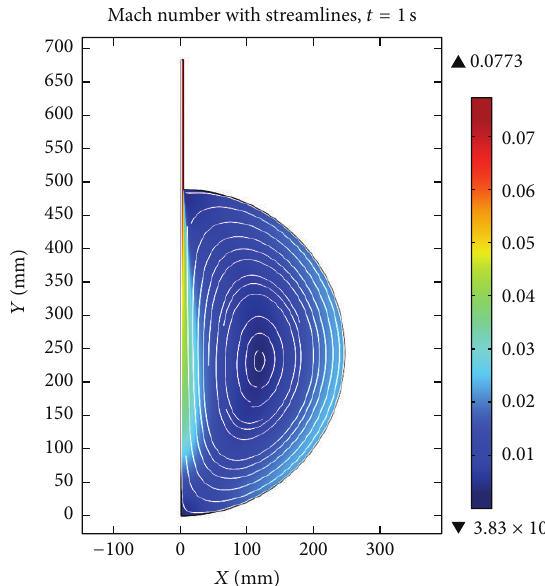
Figure 2: Mach number with streamlines after